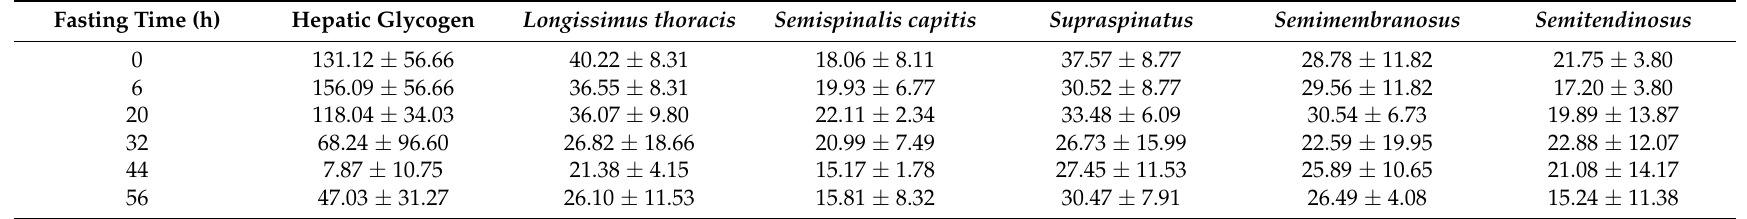
Table 4. Mean ( ± SD) concentrations of glycogen ( µ mol/g) in liver and six muscles of lambs slaughtered at different fasting times (h). Adapted from Carter and Gallo